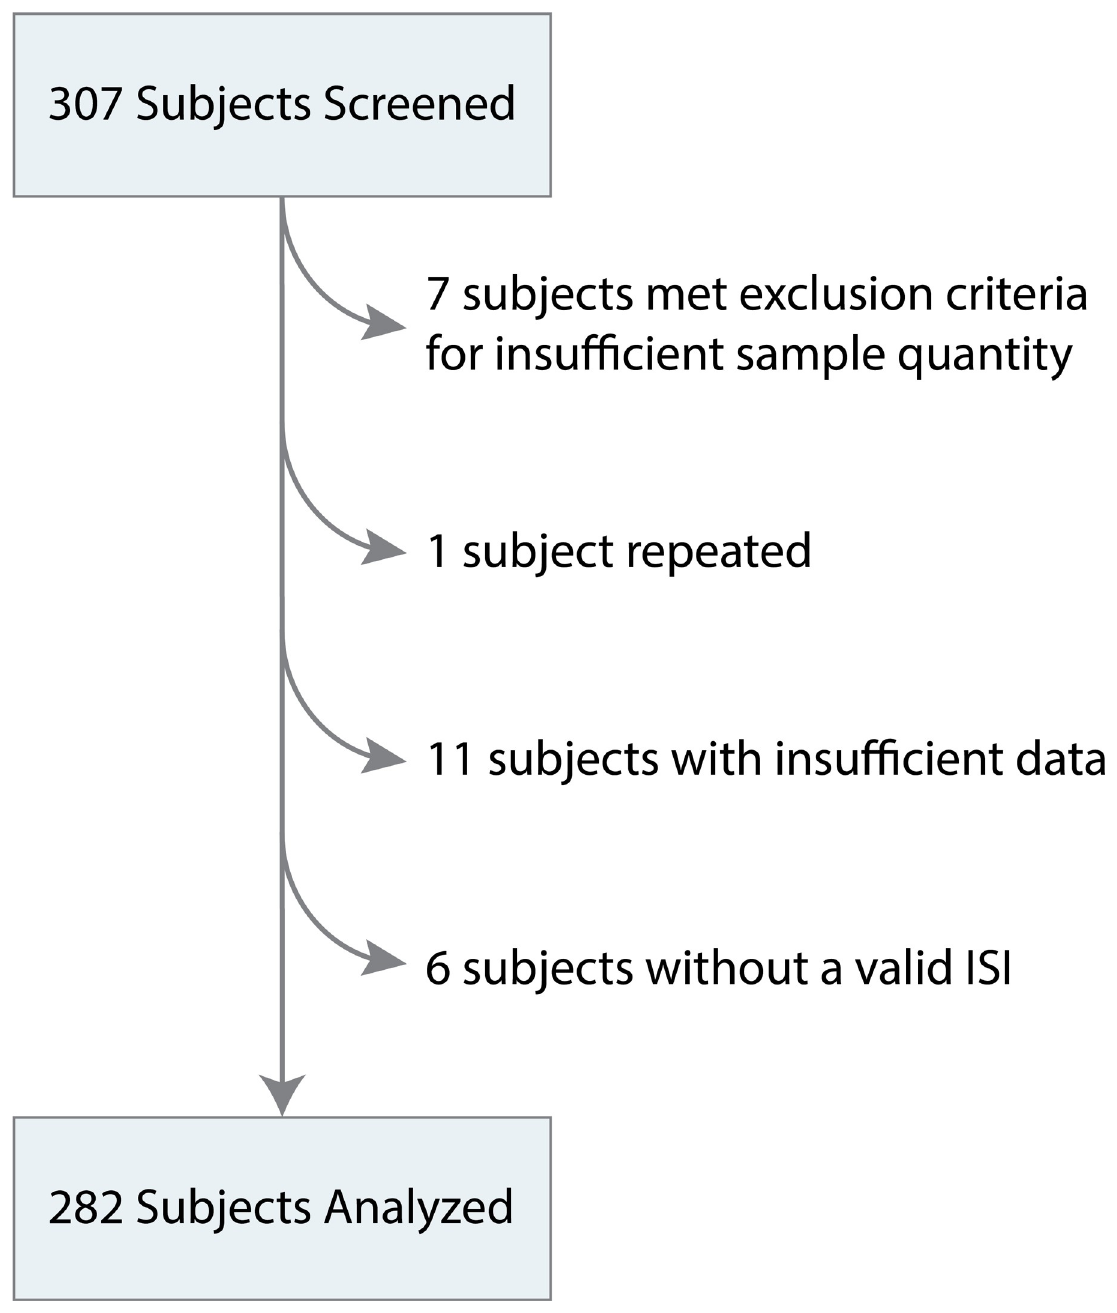
Fig 1. 307 adult patients with suspicion of respiratory infection for which a complete blood count was ordered in the emergency department were screened, 7 subjects met exclusion criteria for insufficient sample quantity and were not enrolled, 1 subject was enrolled repeatedly, and the second enrollment was excluded. Due to user error, test data was not recorded for 10 subjects and for 6 subject samples, testing did not produce a valid ISI. As a result, 282 subjects were included in the study analysis. of 35.0% (Fig 2B). These survival trends continue, with only 55% of those in the red band sur- viving at 15 days, compared to 87% of those in the green band. Of the remaining 186 patients, who were either not tested or were negative for SARS-CoV-2, 129 were in the green band with a 3-day mortality of 1.6% and 7-day mortality of 1.6%; 31 were in the yellow band with a 3-day